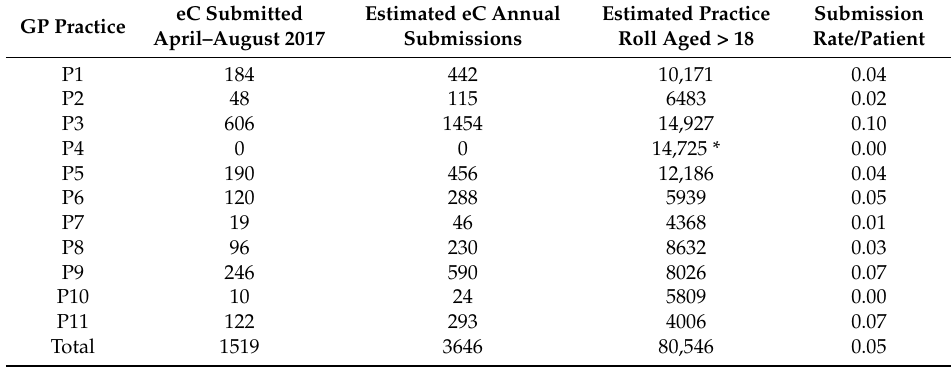
Table A4. eConsult submission rates.